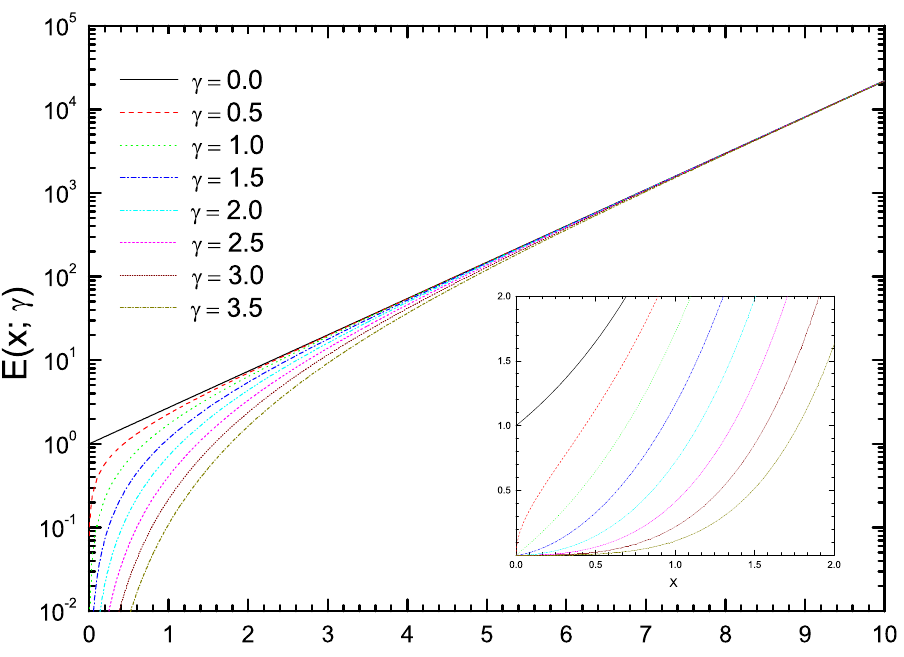
Figure 1. Behavior of γ − exponential function (2). Main panel: this function converges towards usual exponential function for large values of its argument x . Inset panel: it drops to zero when x → 0 + following a power-law of the type E ( x , γ ) ∝ x γ . The γ − exponential function is just the fractional derivative of the exponential function, E ( x , γ ) ≡ d γ ( e x ) / dx γ . After